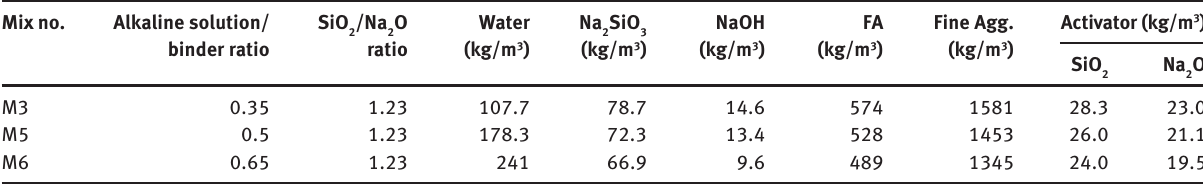
Table 2: Mix proportions of AAFA mortars. Mix no. Alkaline solution/ binder